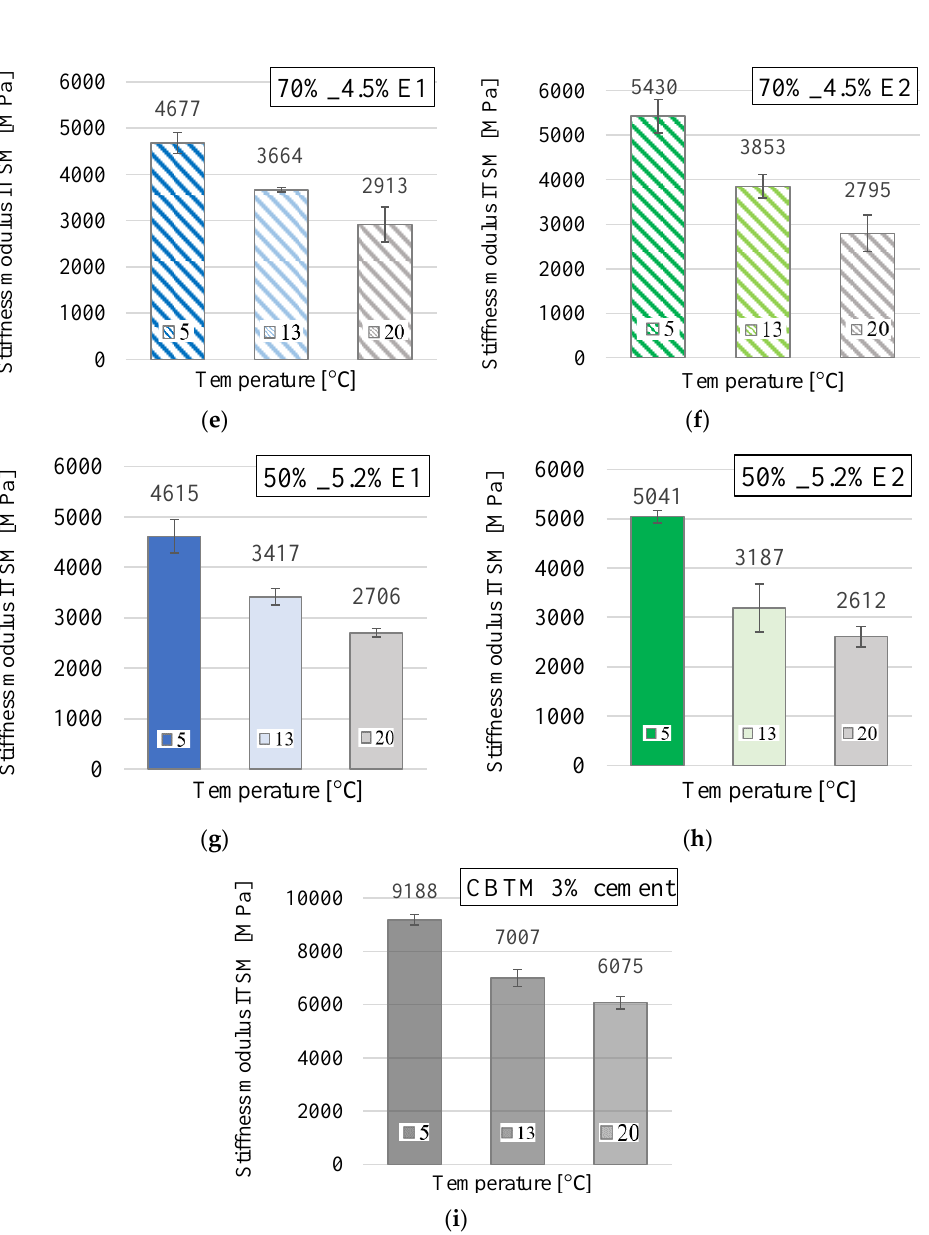
Figure 2. ITSM test results for BSM-E and CBTM mixtures at 5 °C, 13 °C, and 20 °C. ( a ) BSM-E 70%_3.0%E1, ( b ) BSM-E 70%_3.0%E2, ( c ) BSM-E 50%_3.0%E1, ( d ) BSM-E 50%_3.0%E2, ( e ) BSM-E 70%_4.5%E1, ( f ) BSM-E 70%_4.5%E2, ( g ) BSM-E 50%_5.2%E1, ( h ) BSM-E 50%_5.2%E2, and ( i ) CBTM with 3% cement content.